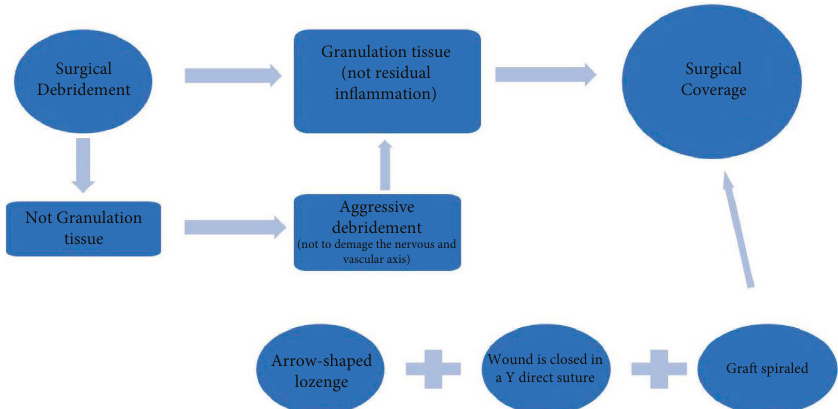
Figure 2: Schema of reconstruction treatment.